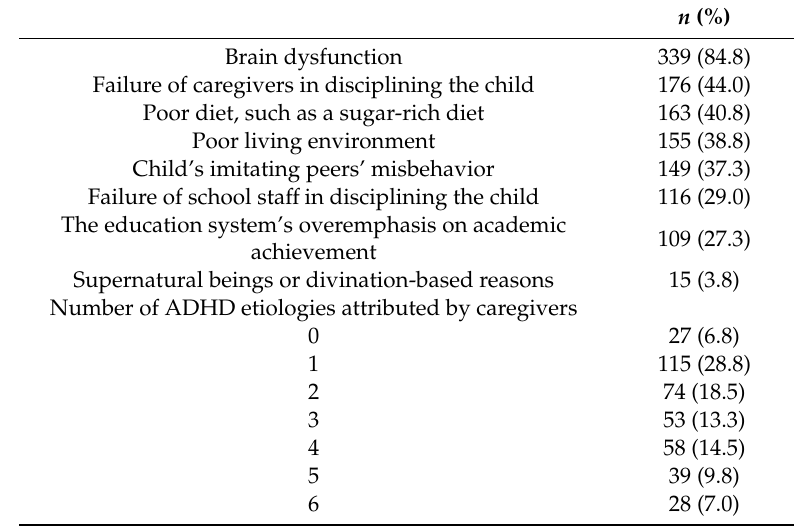
Table 2. Caregiver-attributed etiologies of ADHD (N =